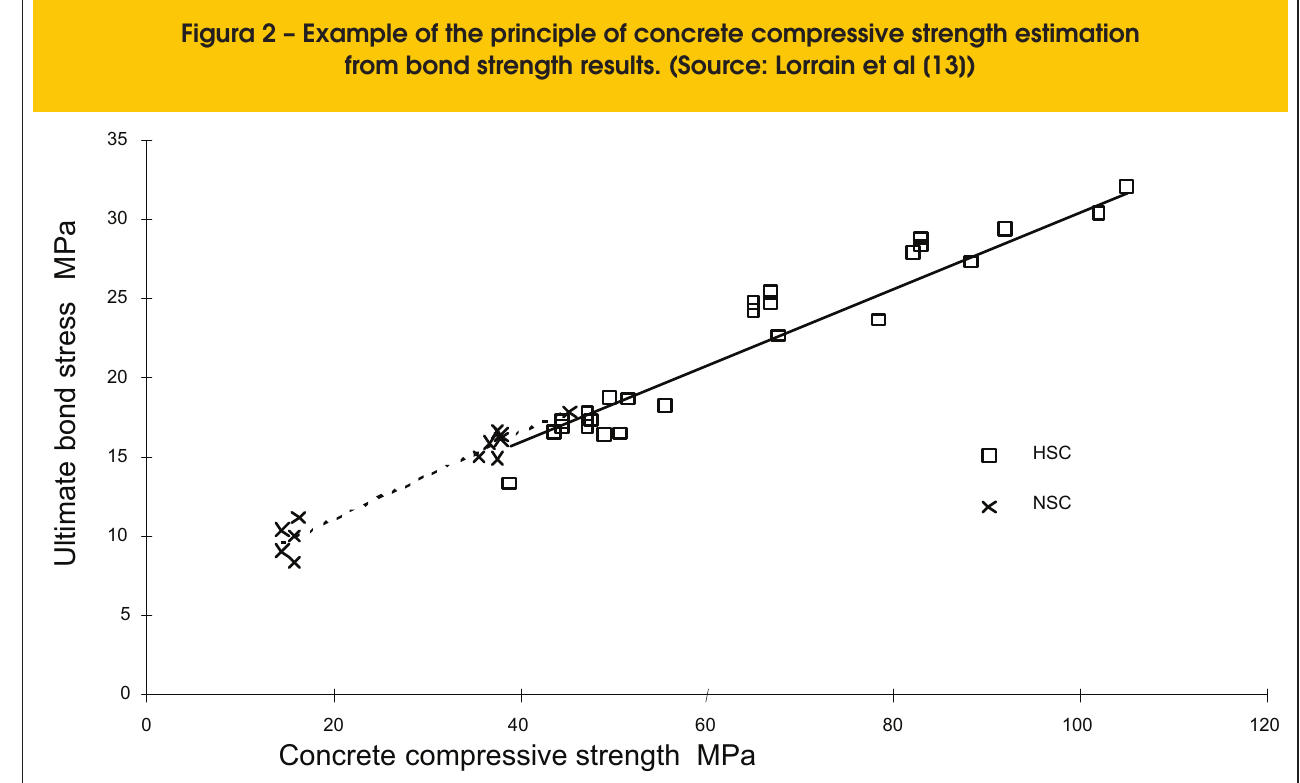
Figura 2 – Example of the principle of concrete compressive strength estimation from bond strength results. (Source: Lorrain et al